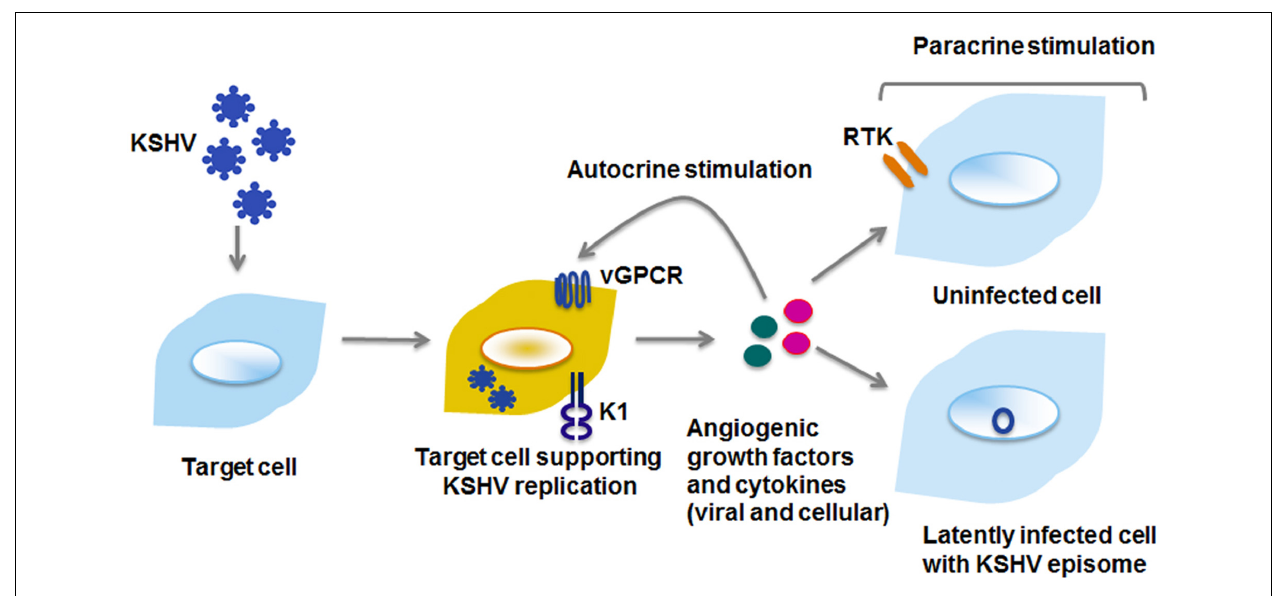
FIGURE 3 |Viral proteins enhance cell proliferation by autocrine and paracrine mechanisms. Viral and cellular cytokines and growth factors can activate signaling pathways within the cell they are secreted from (autocrine), or on distant cells that may either be uninfected or latently infected with KSHV (paracrine). RTK, receptor tyrosine